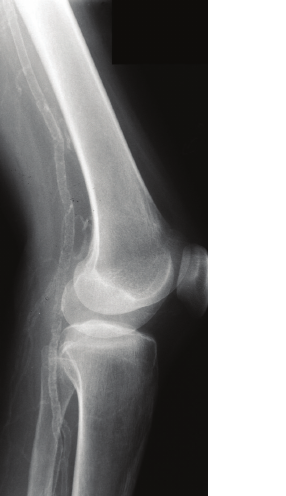
Figure 3: Plain radiograph of right leg showing di ff use vascular calcification of the femoral and popliteal